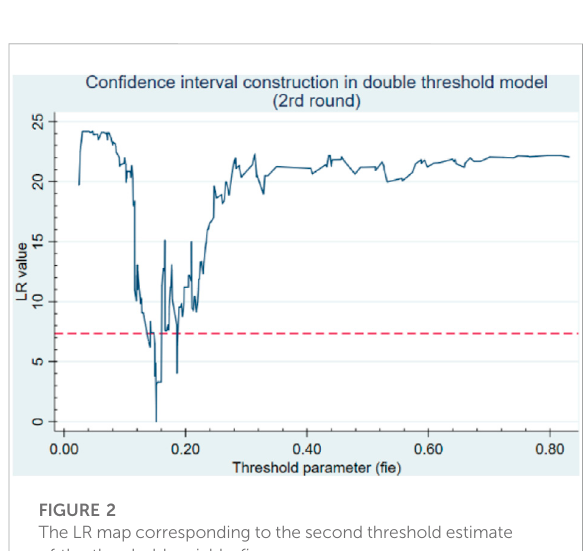
FIGURE 3 The LR map corresponding to the fi rst threshold estimate of the threshold variable iie .